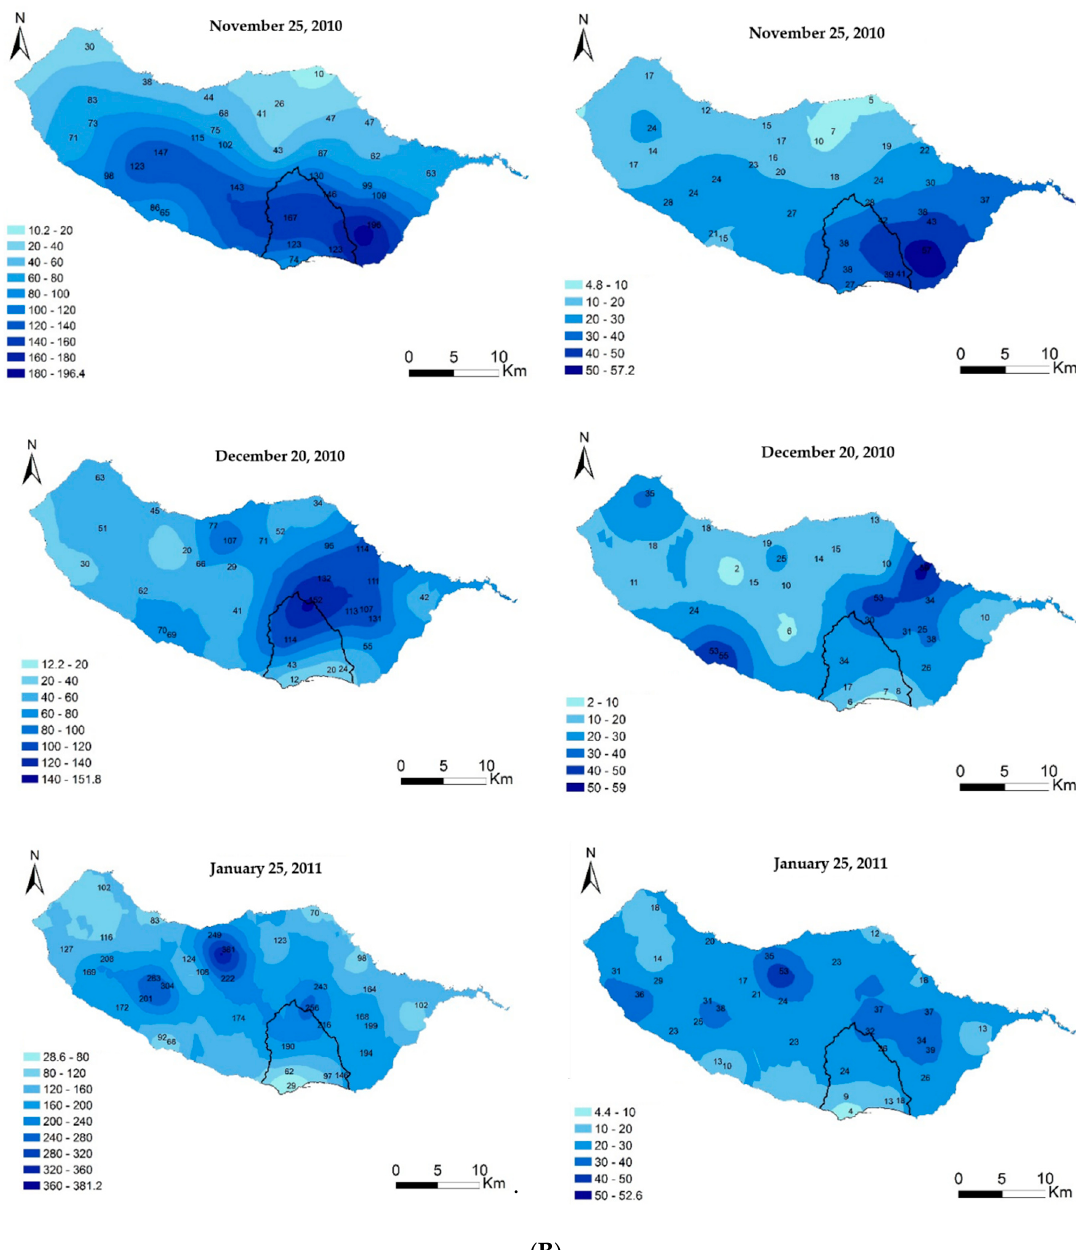
Figure 6. Spatial distribution of maximum precipitation at 12 h (left panels) and at 1 h (right panels), in a group of rainy episodes that occurred between 2009 and 2011. 6A: December 22, 2009; February 2, 2010; October 21, 2010 and 6B: November 25, 2010; December 20, 2010; January 25, 2011.